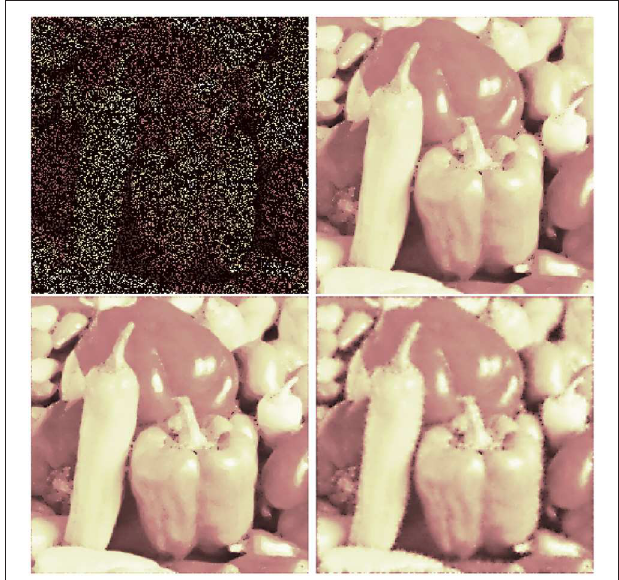
FIGURE 12 | Inpainting for 80% missing pixels: damaged image (top, left), standard TV inpainting (top, right) and spline inpainting of order 3 with TV norm (bottom, left), and squared TV norm (bottom, right).